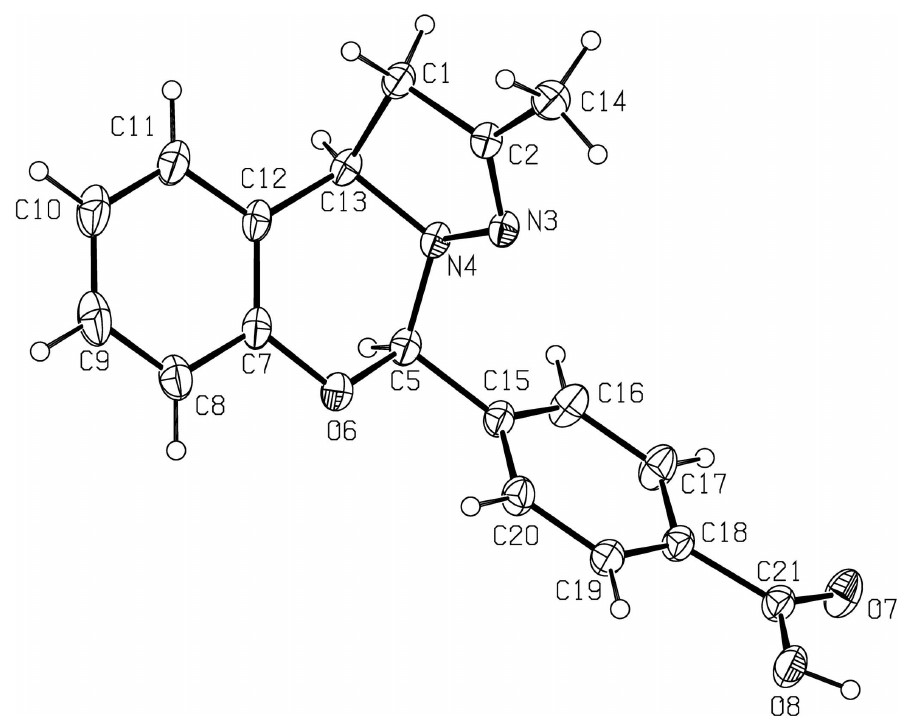
The cis title compound (1a) and its trans isomer (1 b).